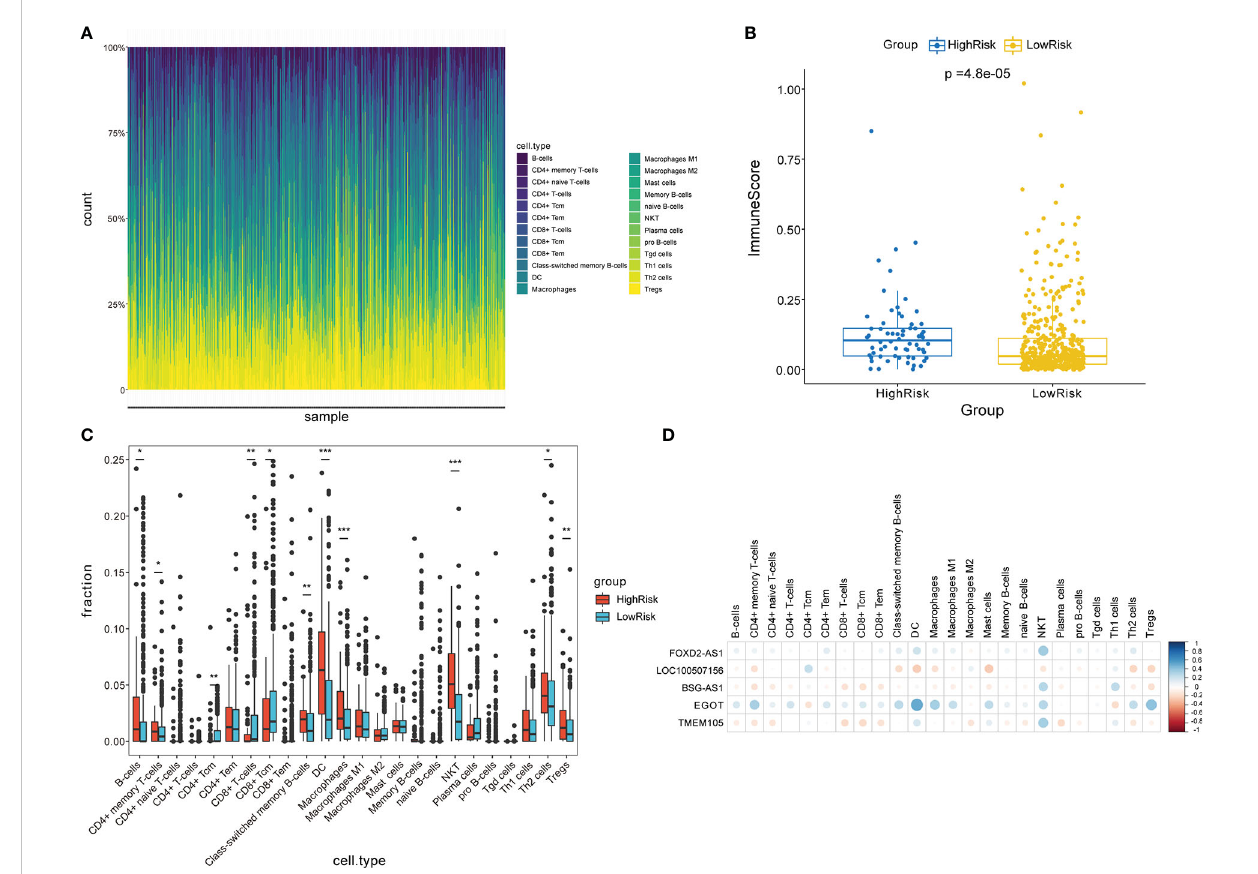
FIGURE 7 Analysis of immune cell in fi ltration in two risk groups strati fi ed by the signature. (A) Overview of immune cell in fi ltration in each patient with PTC in the entire cohort. (B) Comparison of immune scores between two risk groups. (C) Analysis of immune cell in fi ltration in two risk groups. (D) Correlation analyses between fi ve CCR-lncRNAs and immune cell in fi ltration. PTC, papillary thyroid carcinoma; CCR-lncRNAs, cell cycle – related long non-coding RNAs. (* P < 0.05, ** P < 0.01, *** P <